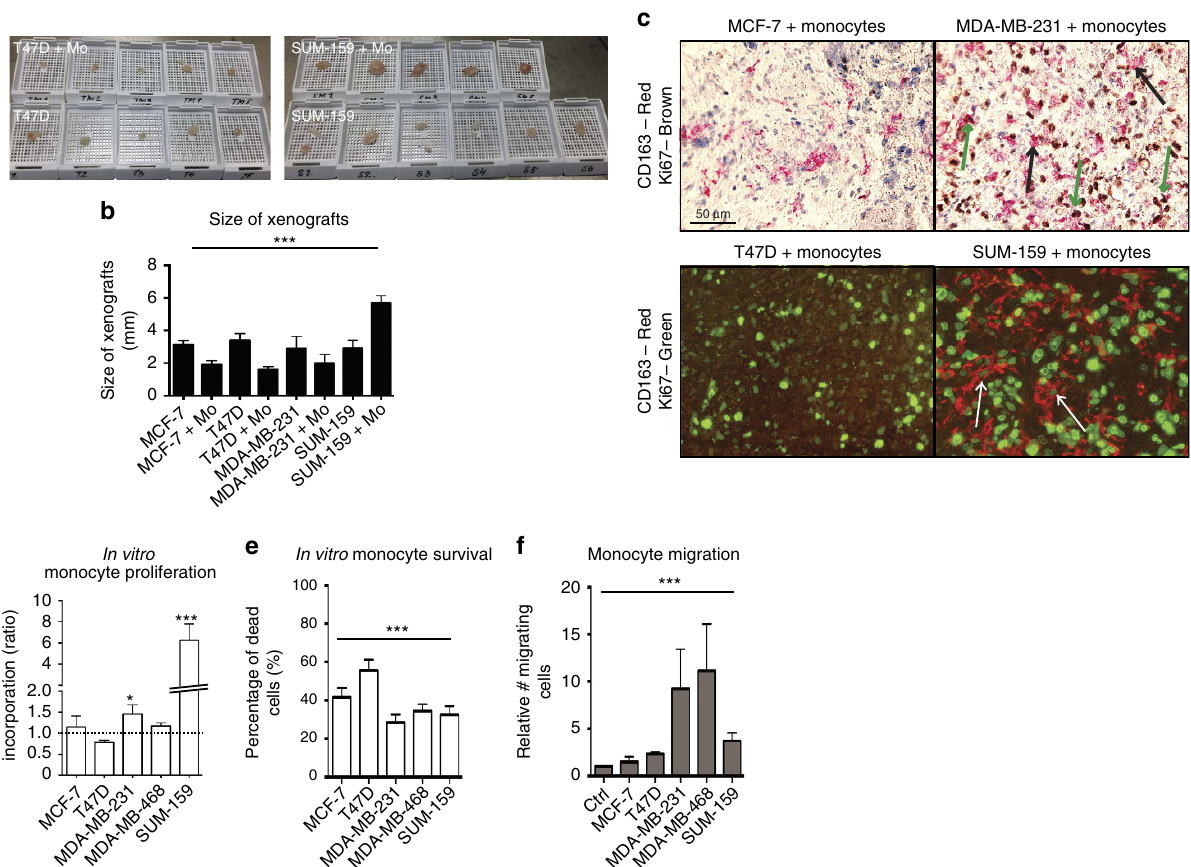
Figure 3 | Characterization of primary monocytes in TNBC cultures. Primary human monocytes show increased proliferation, survival and migration in a TNBC/monocyte environment than in a Luminal A/monocyte context. ( a , b ) The size of the xenografts differed between groups. Co-transplantation of monocytes generally decreased the tumour size slightly ( b ) except in the TN SUM-159/monocyte group, co-transplantation of monocytes (SUM-159 þ Mo) increased tumour growth significantly ( a , b ). *** ¼ P o 0.001 ANOVA. N ¼ 5. ( c ) Myeloid cells proliferate in vivo . Upper panel: Double staining IHC of CD163 and Ki67 in xenografts from MCF-7/monocytes co-transplant (left) or MDA-MB-231/monocyte co-transplants (right) tumours as indicated. Black arrows show single staining with only CD163 and green arrows show double staining. Lower panel: Double staining immunofluorescence of CD163 and Ki67 in xenografts from T47D/monocytes co-transplant (left) or SUM-159/monocyte co-transplants (right) tumours as indicated. White arrows show CD163 þ cells with a clear nuclear Ki67 staining. ( d ) Proliferation of primary human monocyte cultured in control medium or in conditioned medium from different cell lines, was assessed using the thymidine incorporation assay. * ¼ P o 0.05 ANOVA. N ¼ 14. ( e ) Survival of isolated human primary monocytes in breast cancer cell conditioned medium, grown for 7 days, was assessed. Annexin V staining was performed to analyse the total content of apoptotic/dead cells. *** ¼ P o 0.001. ANOVA. N ¼ 5. Error bars indicate s.e.m. ( f ) Boyden chamber migration assay of primary human monocytes migrating towards control medium or MCF-7, T47D, MDA-MB-231, MDA-MB-468 or SUM-159 breast cancer cell conditioned